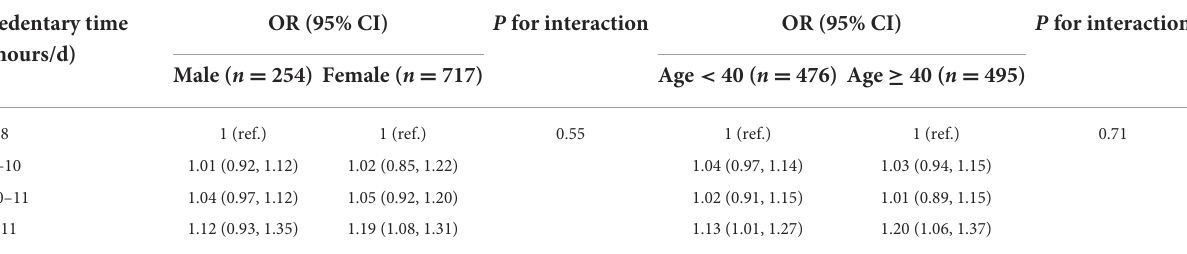
TABLE 3 Association between sedentary time and metabolic syndrome by sex and age group in 971 Tibetans in Garze Tibetan Autonomous Prefecture, Sichuan province,